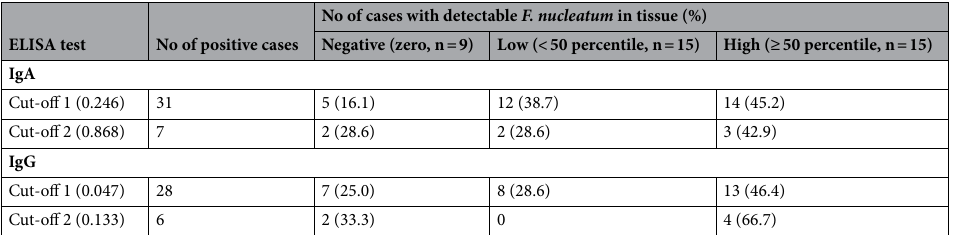
Table 4. Association between F. nucleatum in colon tissue and positivity rate of antibody tests in serum. The positivity criterion is the cut-off that separates normal value (disease free) from abnormal values (indicative of disease).